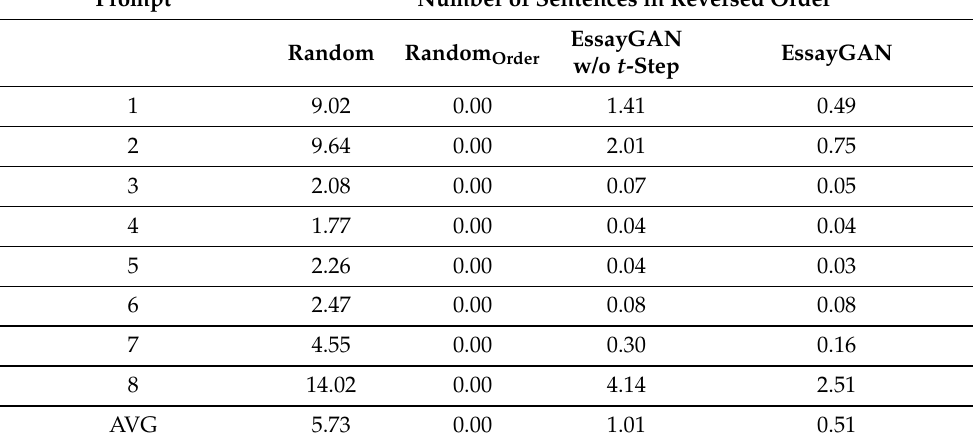
Table 4. Comparison of the number of sentences in reversed order according to the augmenta- tion